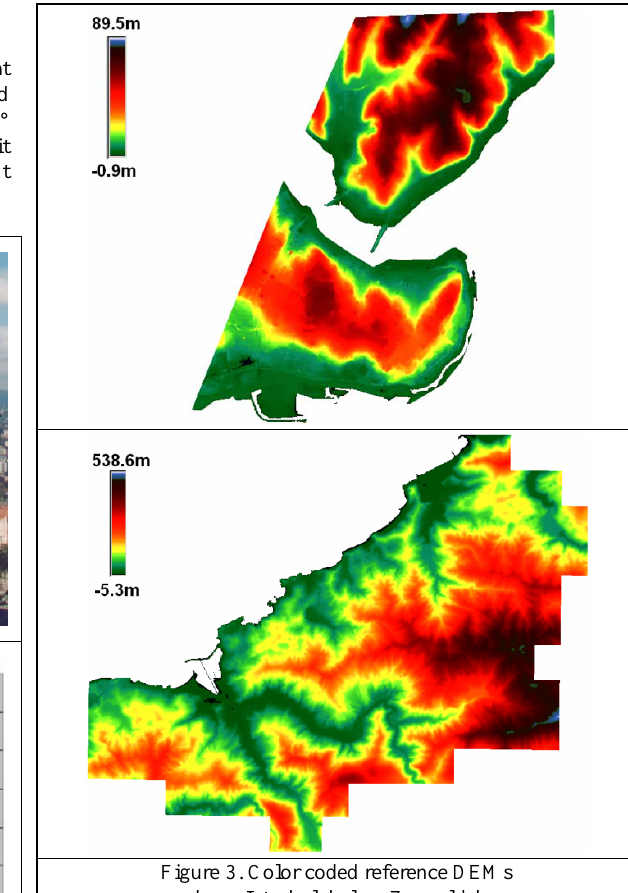
Figure 3. Color coded reference